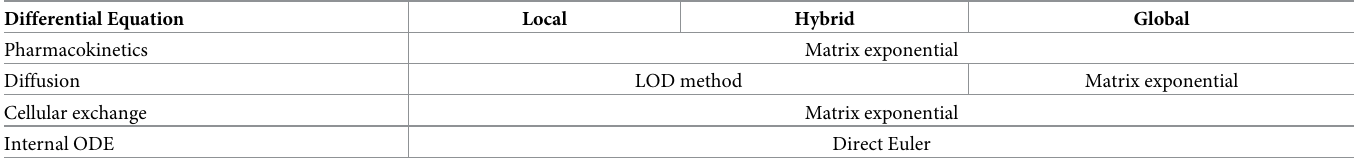
Table 2. Solvers used for each differential equation in the